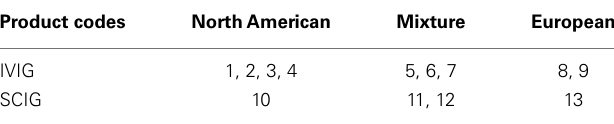
Table 2 | Origin of plasma – assignment of product codes